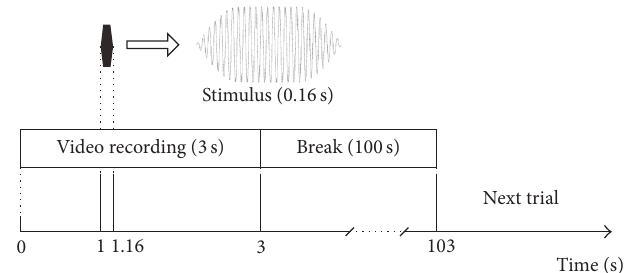
Figure 2: Time course for the measurement of startle response in